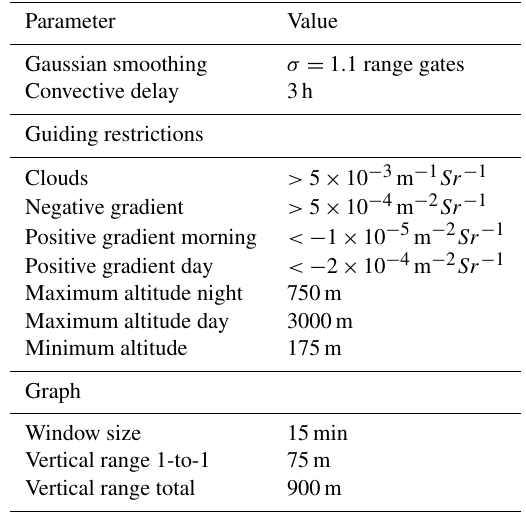
Table 2. Overview of pathfinder parameters applied to Leosphere ALS450 lidar